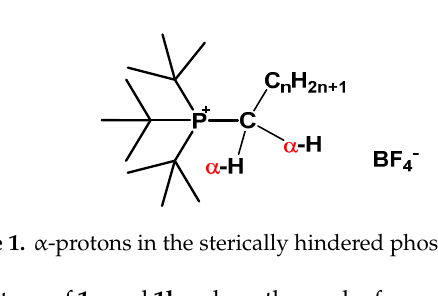
Figure 3. Crystal packing of 5b . Figure 4. Crystal packing of 10b . Crystal packing of 5b is more disordered than the previous one (Figure 3) [56]. Due to a linear alkyl substituent in the structure of phosphonium salt, the location of the molecules in the crystal is more complex. The molecules of 10b are arranged “head to tail” in the crystal (Figure 4). The long alkyl substituents are strictly parallel to each other. Hydrophilic (the head group) and hydrophobic (alkyl side-chain) regions are divided in the crystal packing.